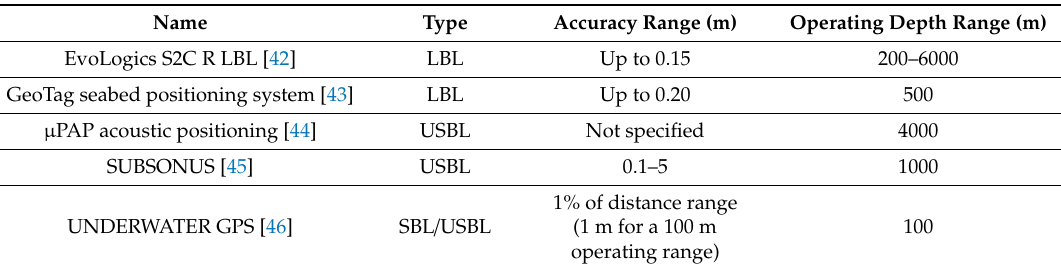
Table 2. Commercial acoustic positioning